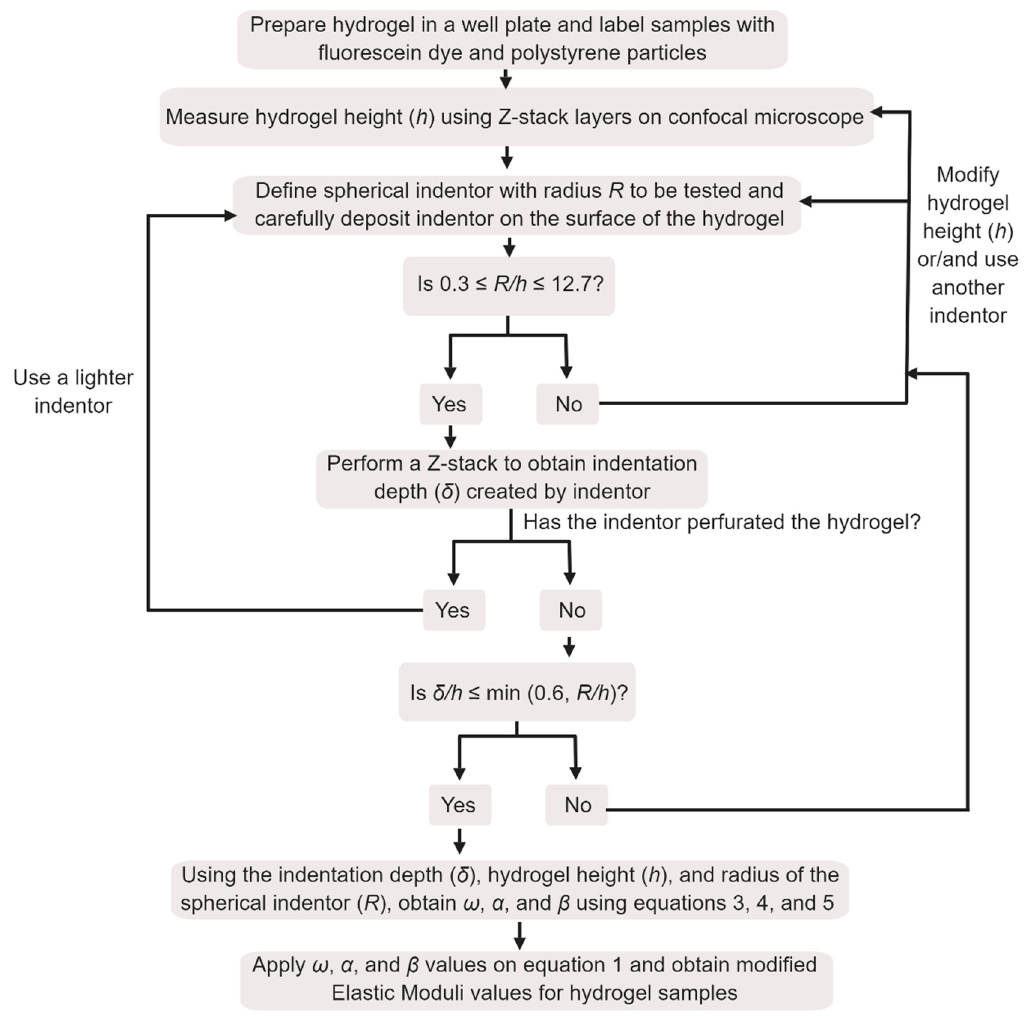
Scheme 1 . Flow chart for determination of elastic modulus using the indentation